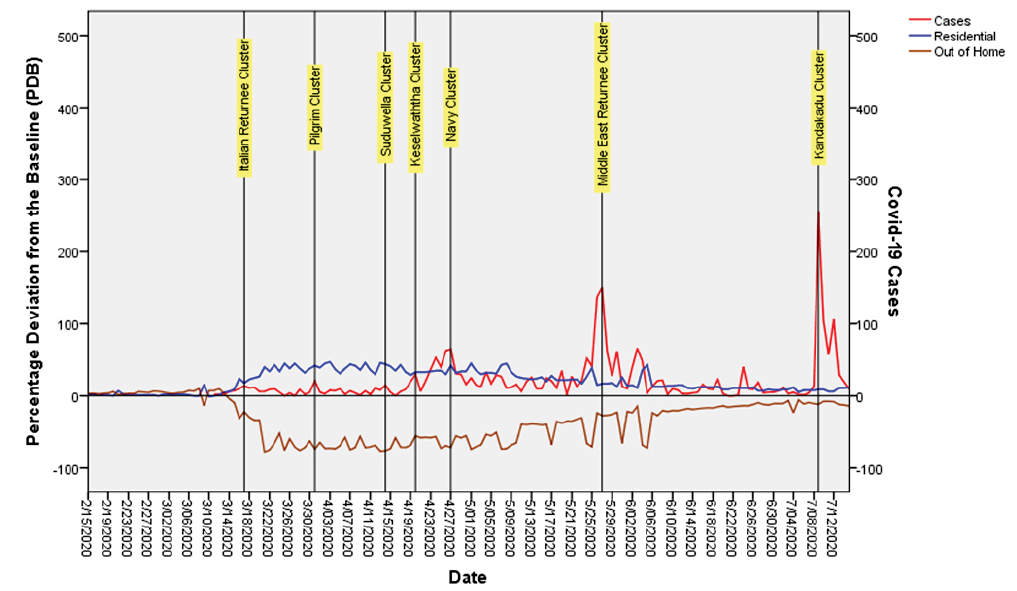
Figure 2: Daily Distribution of Percentage Deviation from Baseline (PDB) at Residential and Out of Home Locations, Covid-19 Cases and Peaks of Clusters